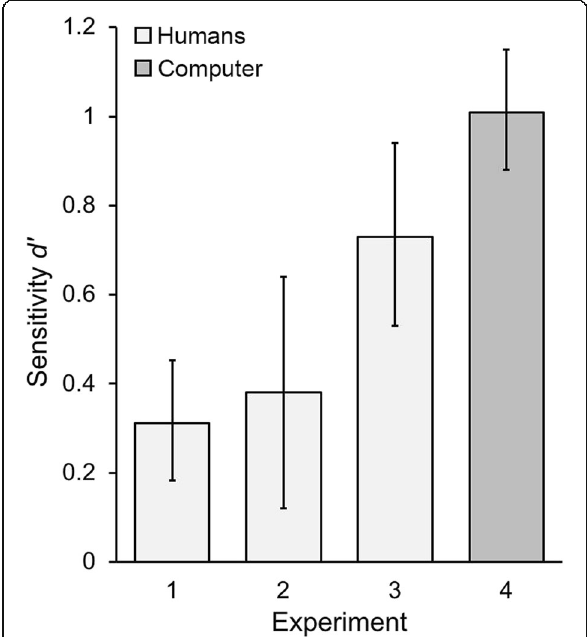
Fig. 4 A comparison of all four experiments. A plot of sensitivity data for the human detection of morphs for conditions where the morph detection tips were provided beforehand ( light gray ), along with the computer model ’ s performance ( dark gray ). Error bars represent 95% confidence